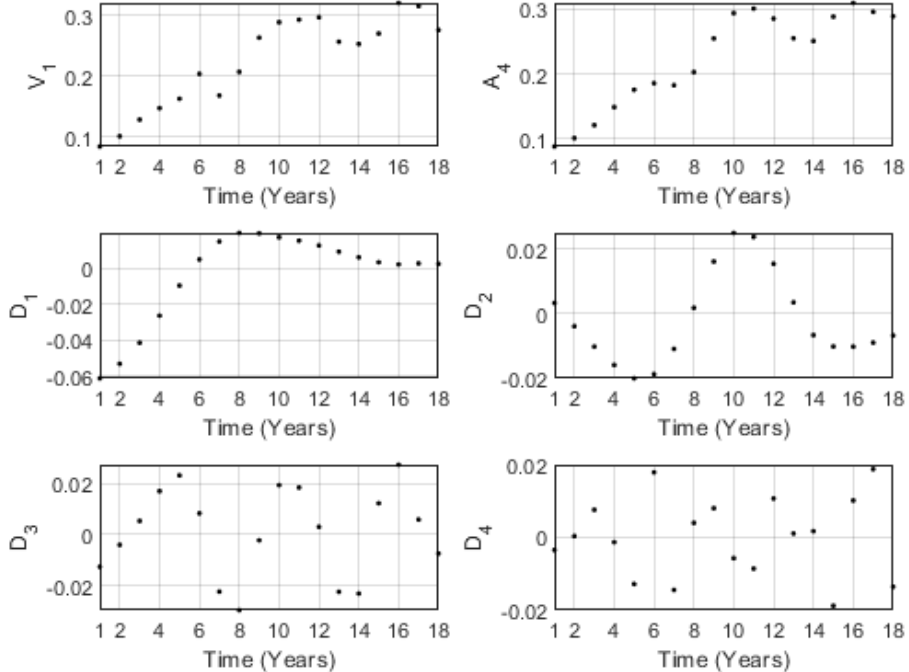
Figure 1. The wavelet decomposition of the variable V 1 at the level